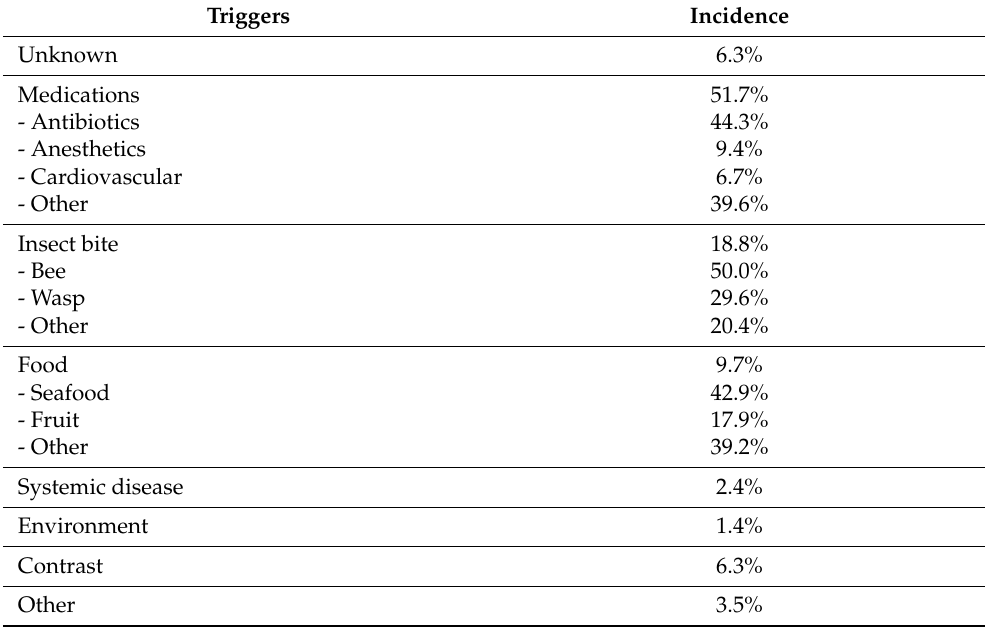
Table 3. Incidence of the triggers leading to allergic reaction complicated by Kounis Syndrome.